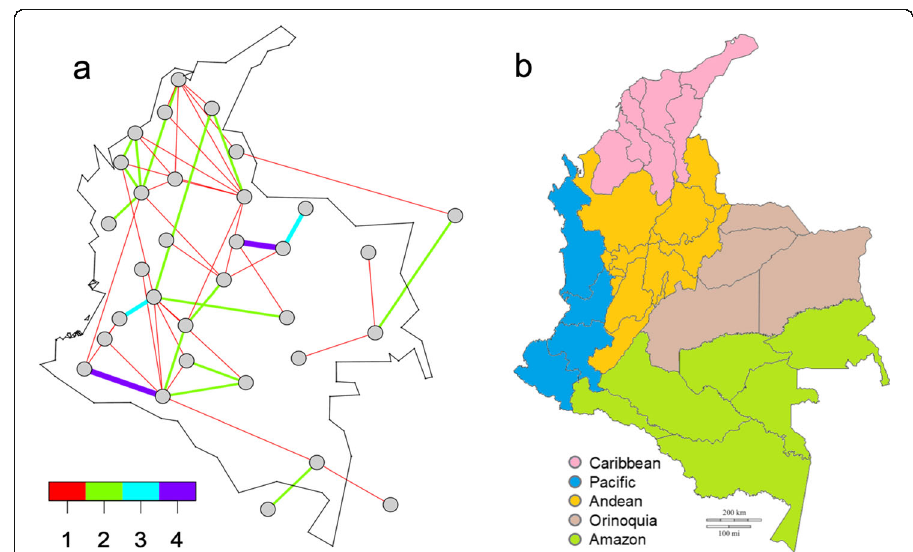
Fig. 2 Network representation of reptile trafficking in Colombia. a Nodes correspond to departments (national geopolitical subdivisions) and links indicate the number of reptilian families traded across each border, as indicated by the color scale. Nodes outside of the map border represent neighboring countries. b Administrative division of Colombia into departments. Colors indicate the dominant climate zone in each department. Social, economic and biotic similarities between departments is higher within than between